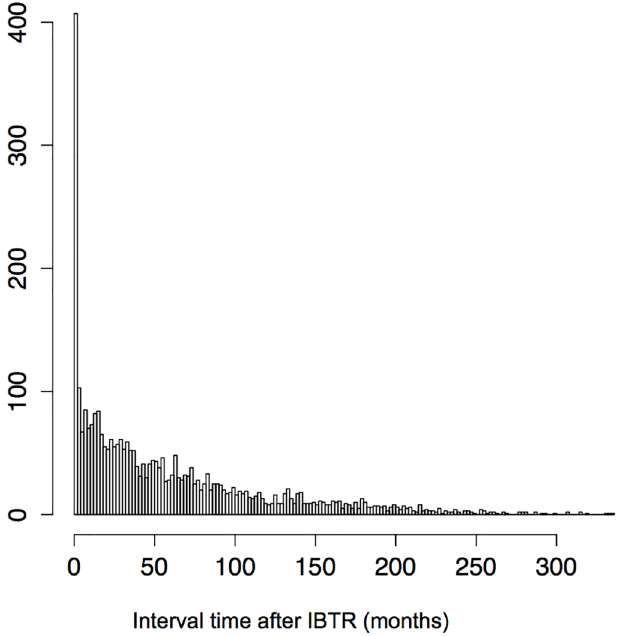
Fig 1. Distant disease occurrence according to time after IBTR for overall population. Vertical bars represent the number of events. Width of vertical bars stands for 3 months.